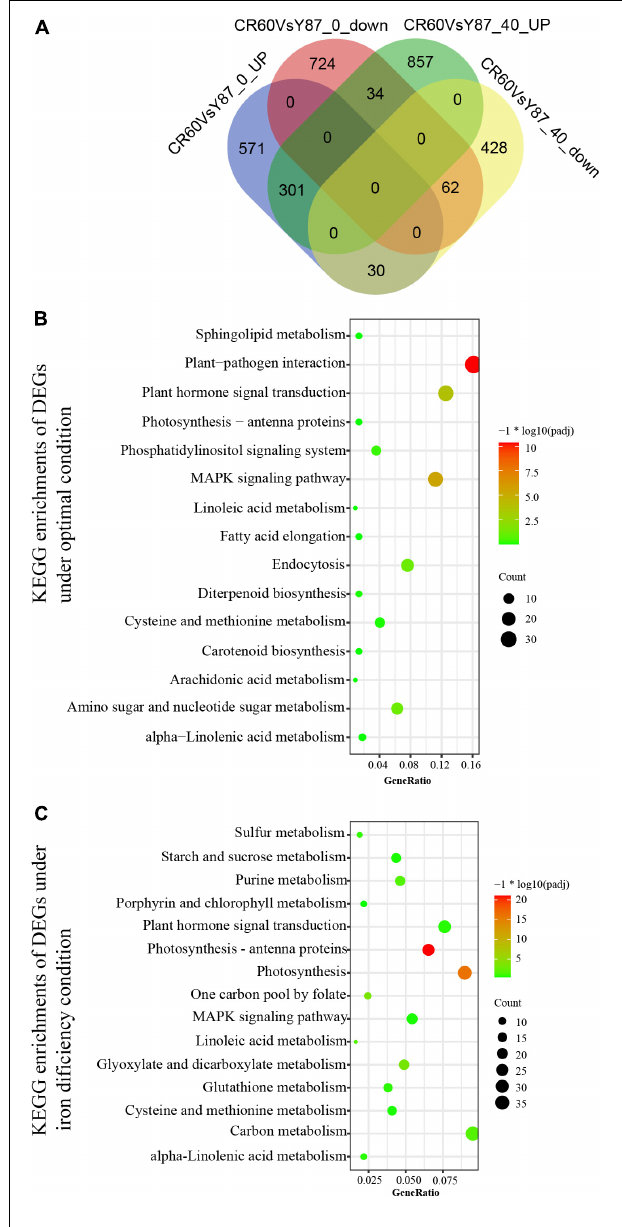
FIGURE 4 | Comparison of iron starvation-regulated transcriptome between CR60 and Y87. (A) Venn diagram showing DEGs between CR60 and Y87 under optimal and iron deficiency conditions. KEGG enrichments of DEGs under optimal conditions (B) or iron deficiency (C) .